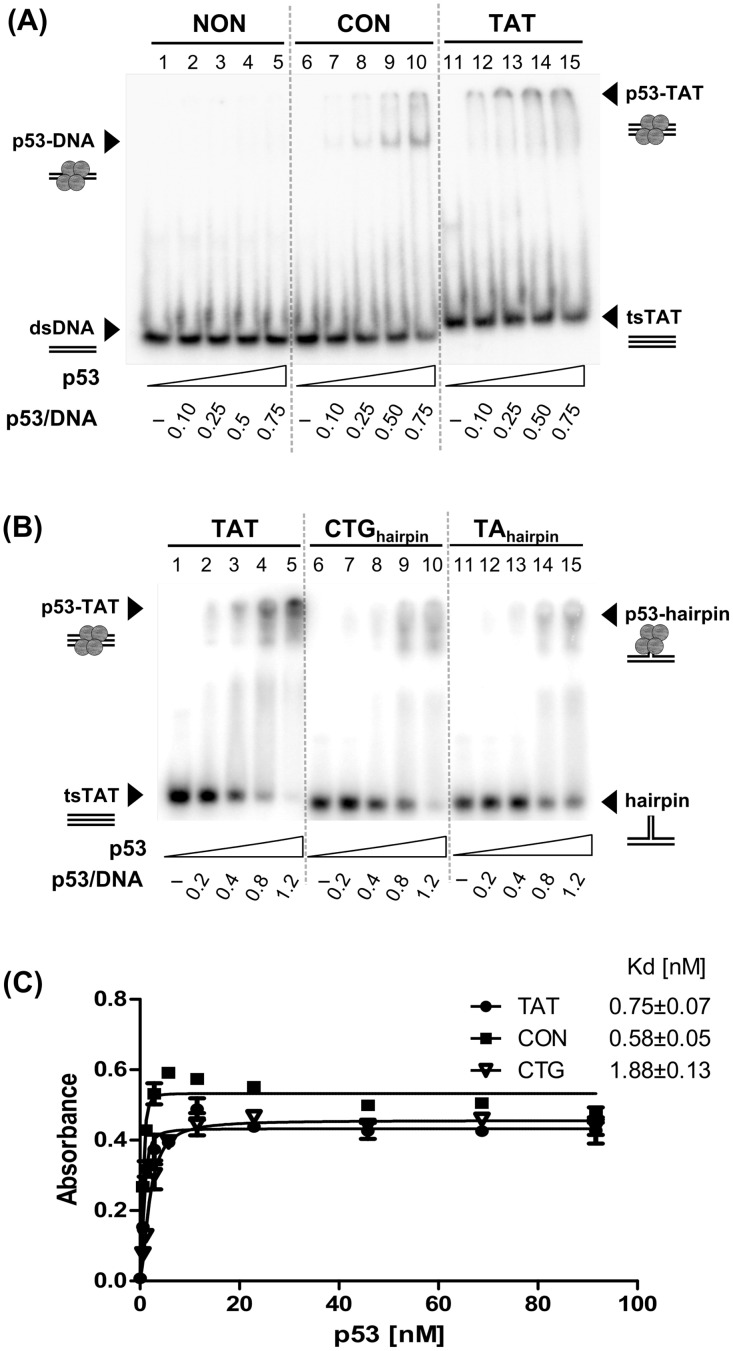
Full length p53 binds strongly to T.A.T triplex DNA.(A) Full length p53 was incubated with 1 pmol of 32P-labeled 50-mer oligonucleotides: nonspecific dsDNA (NON, lanes 1–5), p53 specific dsDNA with CON (CON, lanes 6–10) and (dT)50.(dA)50.(dT)50 triplex (T.A.T triplex, lanes 11–15) in presence of 50 ng pBSK/SmaI. Molar ratios of p53 tetramer/DNA ranged between 0.1 and 0.75. The samples were loaded onto 5% 0.5 × TBM (2 mM MgCl2) polyacrylamide gel and electrophoresis was performed for 0.45 h. (B) Full length p53 was incubated with 1 pmol of 32P-labeled (dT)50.(dA)50.(dT)50 triplex (T.A.T triplex, lanes 1–5), CTG hairpin (lanes 6–10) and TA hairpin (lanes 11–15) oligonucleotides in presence of 50 ng pBSK/SmaI. Molar ratios of p53 tetramer/DNA ranged between 0.2 and 1.2. The samples were loaded onto 5% 0.5 × TBM (2 mM MgCl2) polyacrylamide gel and electrophoresis was performed for 0.45 h. (C) p53 binding to biotinylated oligonucleotides by ELISA. p53 binding curves for the TAT, CON and CTG oligonucleotides are shown, and the dissociation constants (Kd) are indicated.